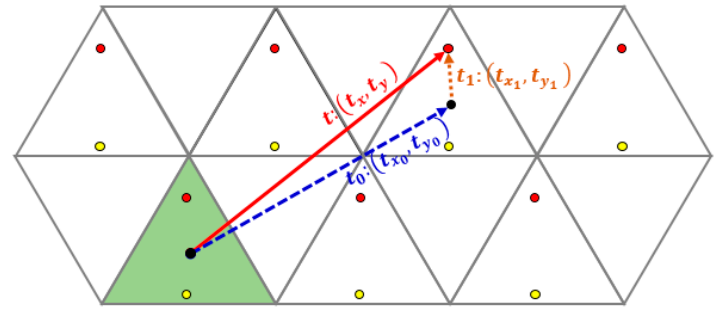
Figure 5. A translation vector t is considered as the sum of two vectors; t 0 is the “integer” vector, and t 1 is the “fractional” vector.